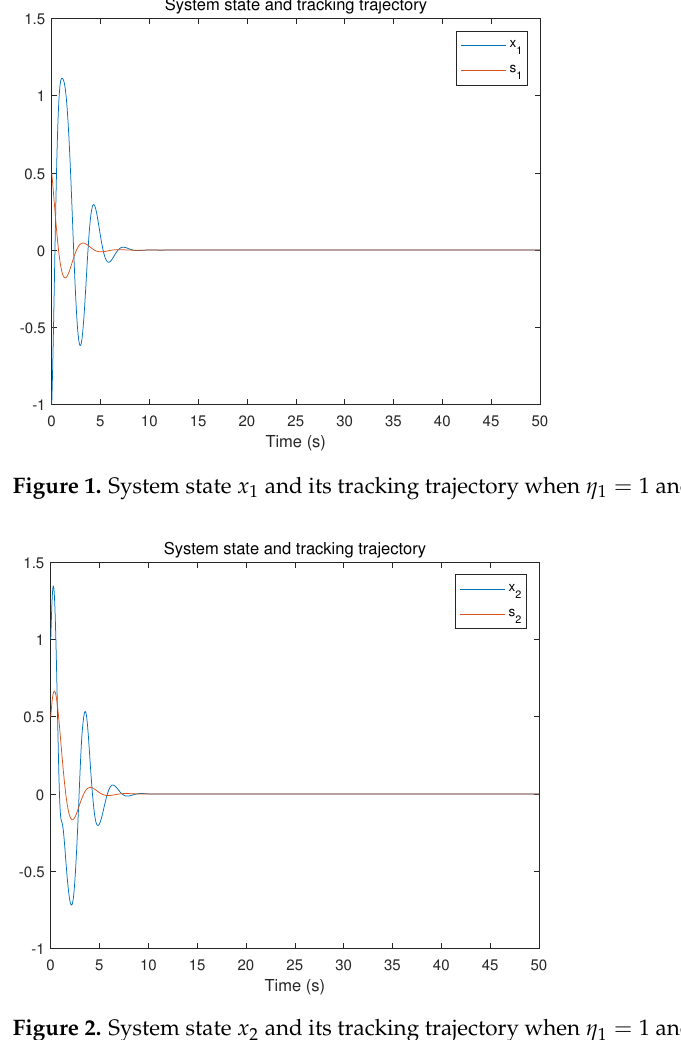
Figure 2. System state x 2 and its tracking trajectory when η 1 = 1 and η 2 = −